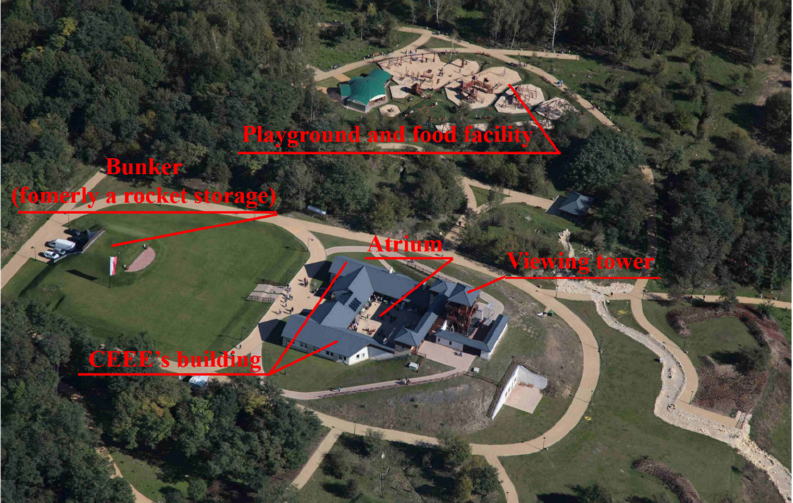
Figure 1. The area of So ś nia Góra in the Silesian Botanical Garden in Miko ł ów, Poland—general view (source: phot. of Janusz Moczulski, 2013); available thanks to 2013 Pawe ł Kojs’ permission).